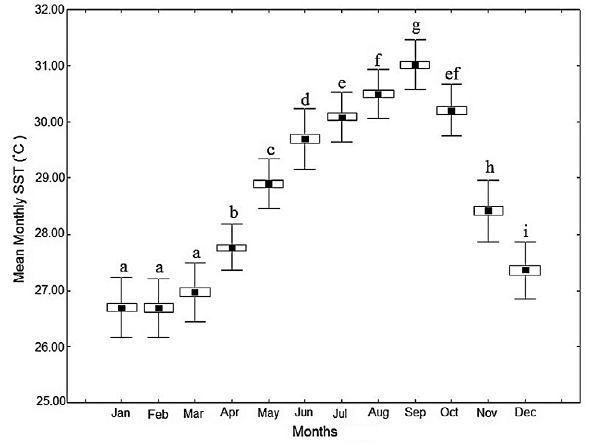
Fig. 4. – Monthly mean SST (°C) for the 2003-2017 period. The boxes represent mean±SE and the vertical bars represent mean±SD. The letters represent the differences recorded.